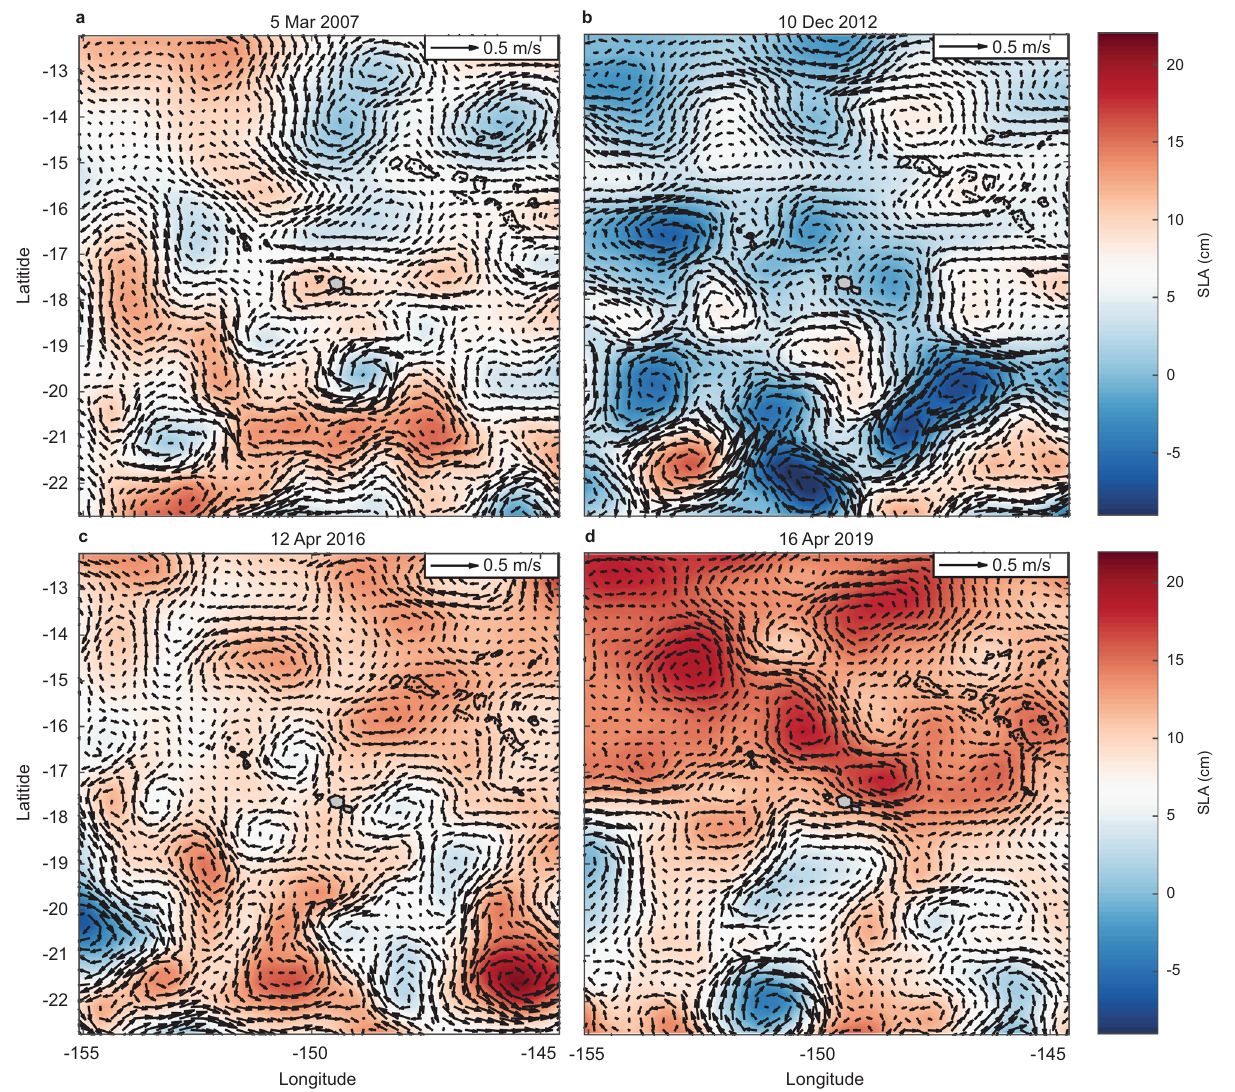
Fig.10|Comparisonofregionalmesoscalesealevelanomalies(SLAs)andeddy fi elds around Moorea during the surface marine heatwaves (MHWs) of 2007, 2012, 2016 and 2019. Plots show SLAs from satellite altimetry on a 5 Mar 2007, b 10 Dec2012, c 12April2016, and d 16April 2019, highlighting the a elevated SLA around Moorea during the minor subsurface MHW in 2007, b regional SLA depression during the surface-restricted MHW in 2012, c lower regional SLA and a